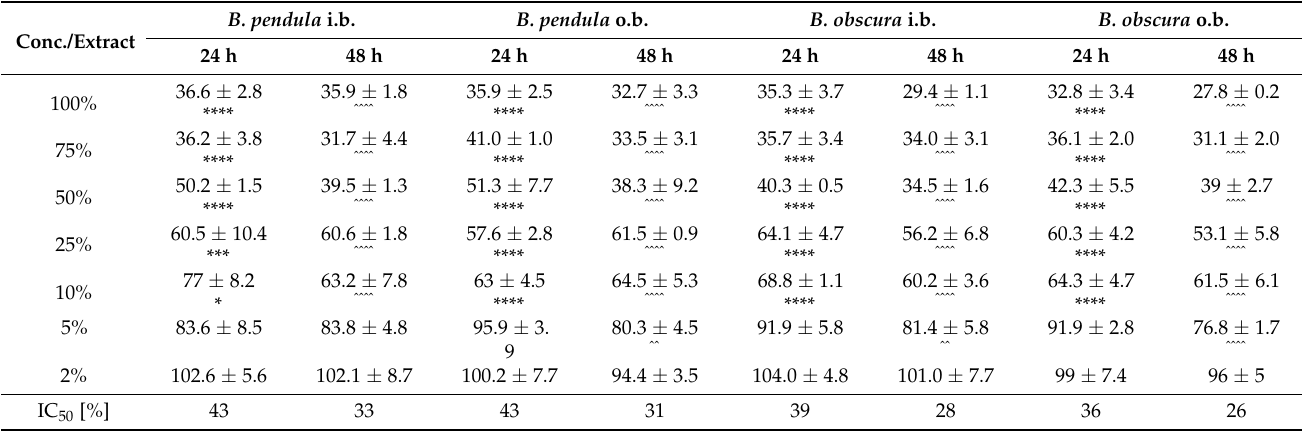
Table 3. Table summarizing percentage of cell viability after the exposition to the tested extracts, acquired by MTT assay after 24 and 48 h incubation. One hundred percent of viable cells correspond to the values obtained in the control culture (0% extracts). Data presented as the means ± SD. Conc./Extract